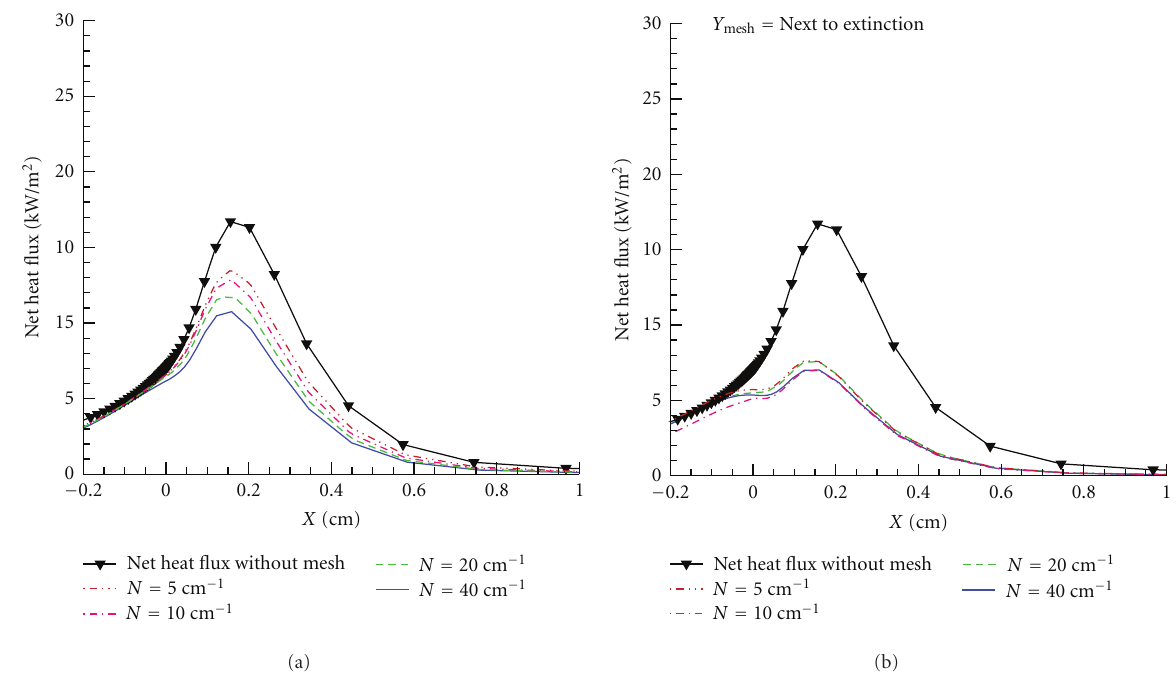
Figure 7: E ff ect of N on net heat flux. (a) Y mesh = 0.75 cm and (b) Y mesh = near